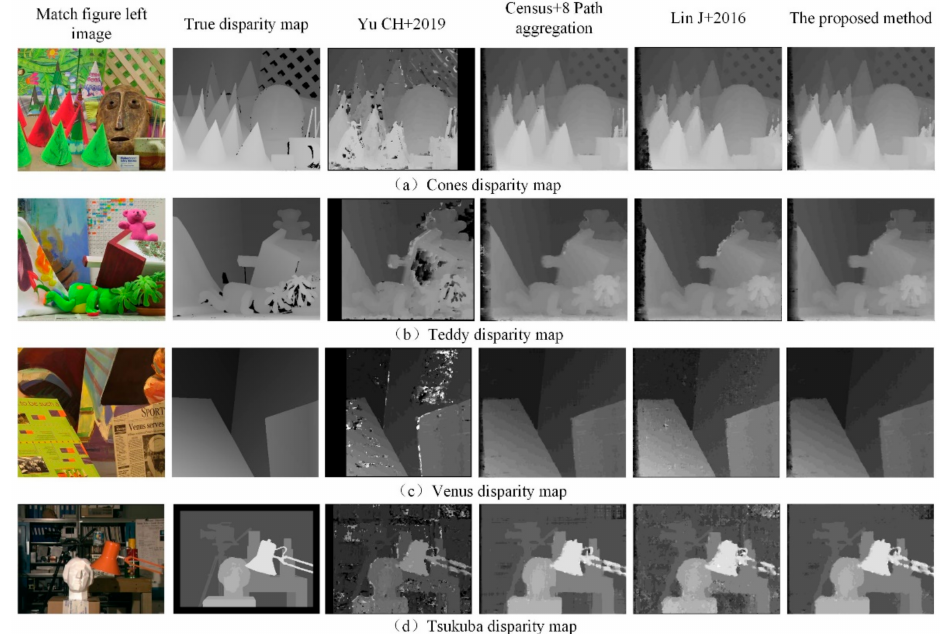
Figure 7. Comparison of test image disparity maps obtained by different algorithms